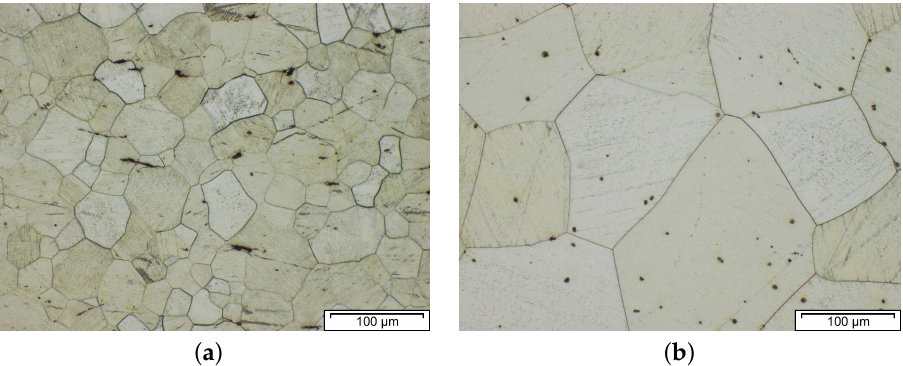
Figure 4. Comparison of the grain size within a forged and solution heat-treated low-alloyed Mg alloy containing REE. Showing the microstructure ( a ) with Zr additions (~0.4 wt.%) and ( b ) without Zr. Experiments performed at LKR Light Metals Technologies